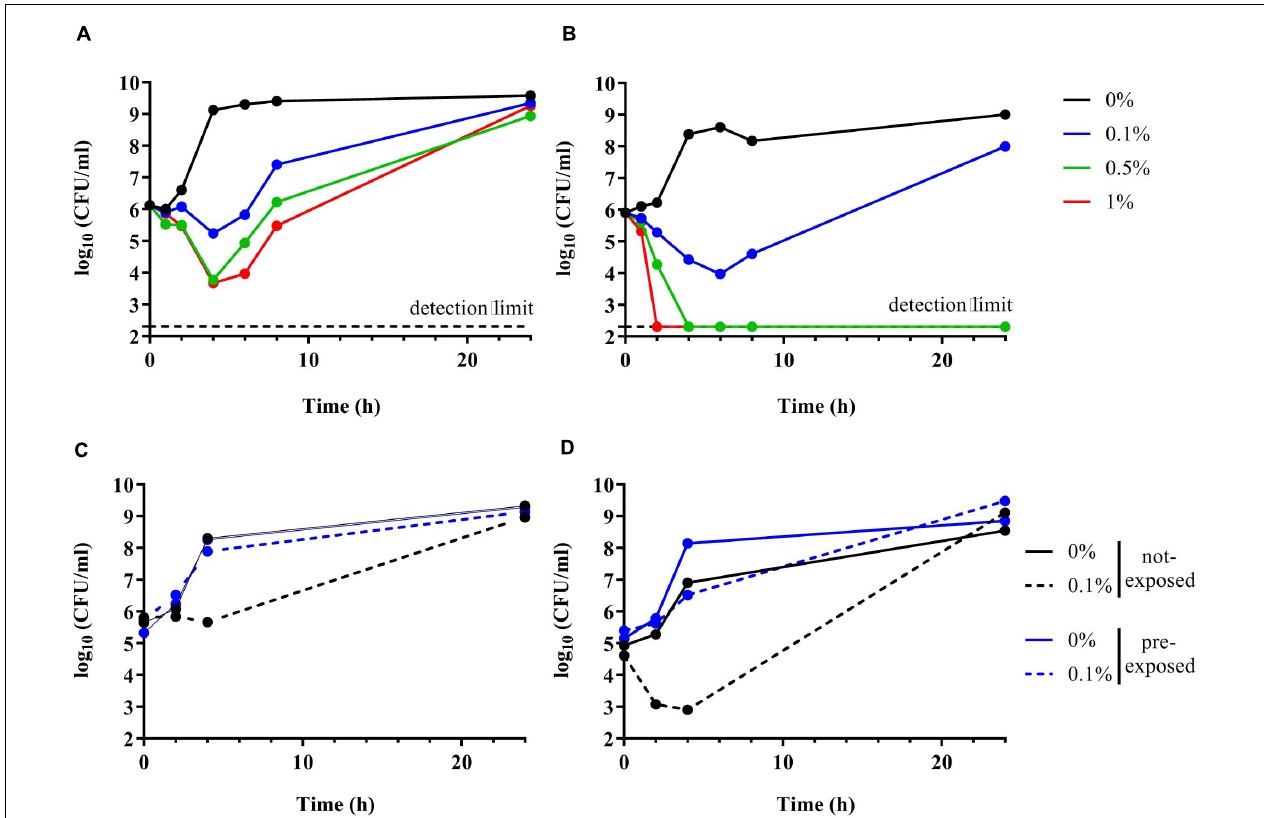
FIGURE 5 | Time kill curve of AIEC WT and (cid:49) ompR mutant in presence of DOC. (A,B) The WT AIEC strain S136 (A) and its (cid:49) ompR mutant (B) were grown in LB without DOC (black line) or with 0.1% (blue line), 0.5% (green line), and 1% DOC (red line). (C,D) The S136 WT (C) and (cid:49) ompR mutant (D) recovered after 24 h of an LB culture without DOC (not-exposed, black line) and with 0.1% DOC (pre-exposed, blue line) (see Figures 5A,B ) were grown again in LB without DOC (filled line) and with 0.1% DOC (dotted line). Data representative of at least two independent